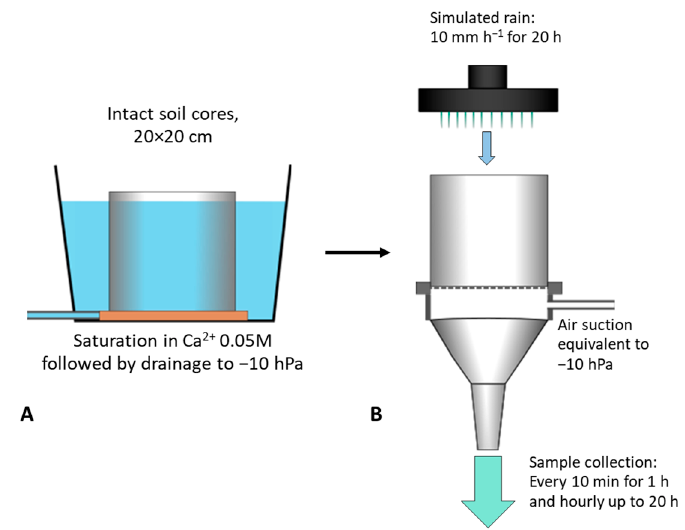
Figure 1. Sample preparation ( A ) and leaching experiment ( B ) setup. Preparation consisted of saturating intact soil cores in a simulated soil solution followed by drainage and equilibration at − 10 hPa. In the leaching experiment, the soil cores were irrigated with simulated rain at a rate of 10 mm h − 1 for 20 h, while leachate was collected.